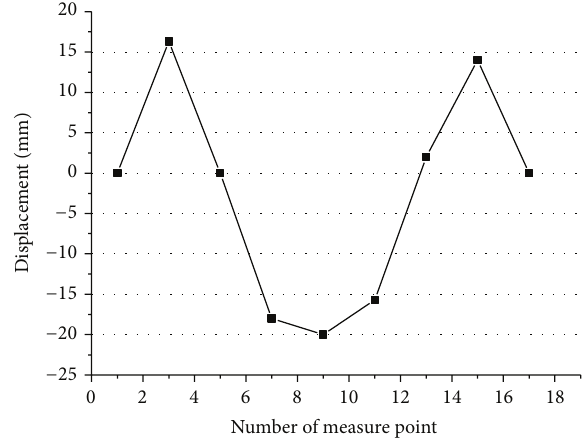
Figure 17: Displacement changes in the box girder.